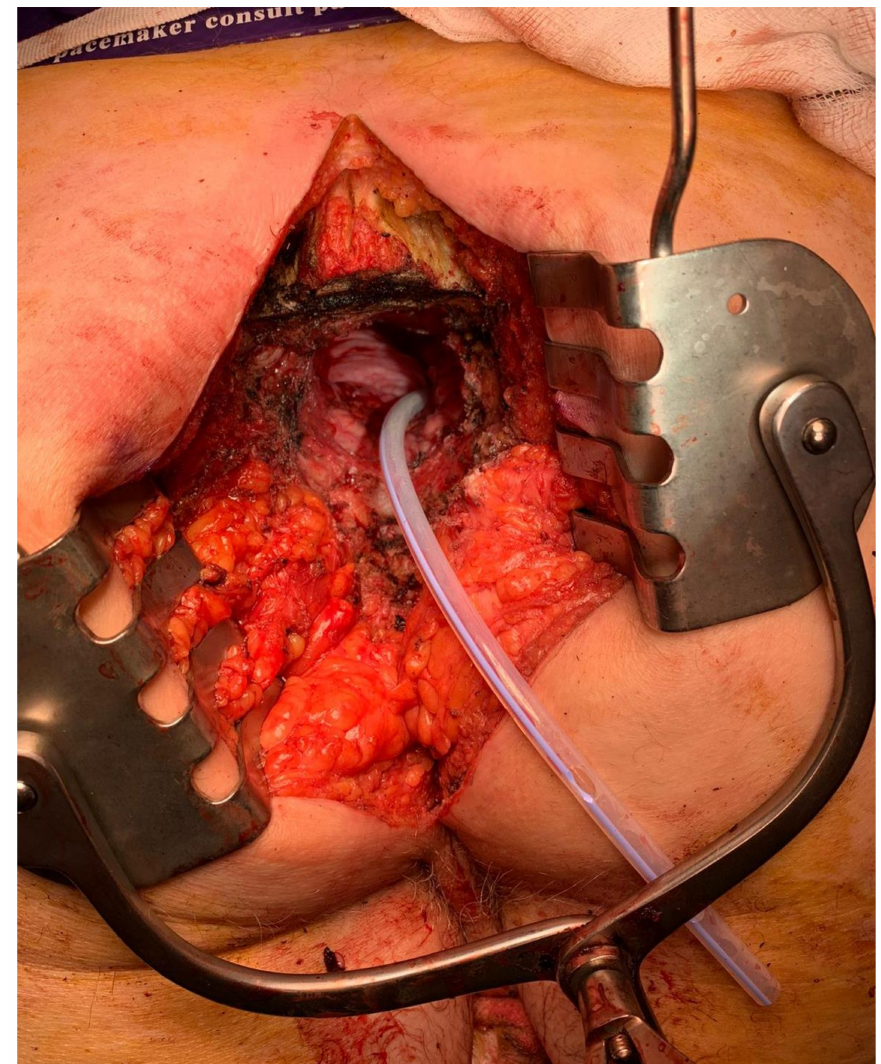
Figure 3. Prone view into pelvis after S3 sacral transection and specimen removal. Robinson’s drain can be seen coming from the pelvis, with St. Mark’s perineal retractor in